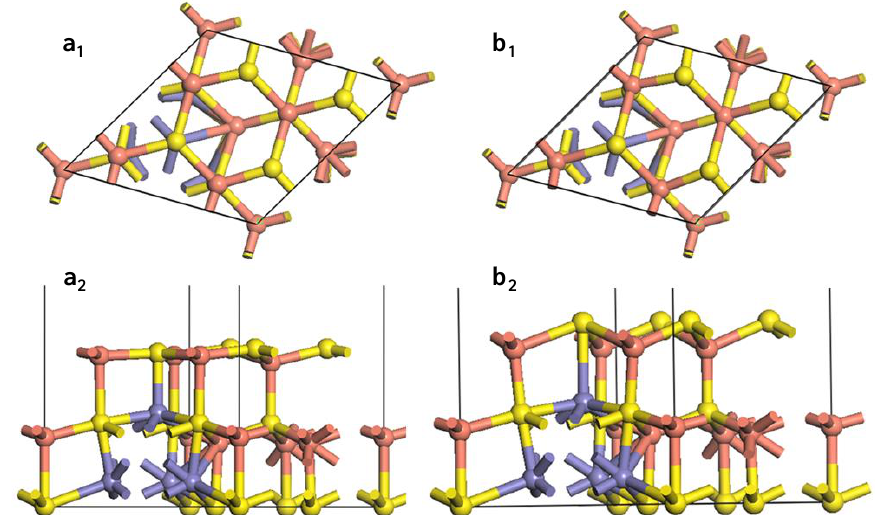
Figure 4. Reconstruction of bornite (111)-S surface in DFT calculation (CASTEP module of Materials Studio 6.0 software package, PBE density function, Hubbard + U correction): ( a 1 ) Top and ( a 2 ) side views of optimized (111)-S surface; ( b 1 ) Top and ( b 2 ) side views of initial (111)-S surface.